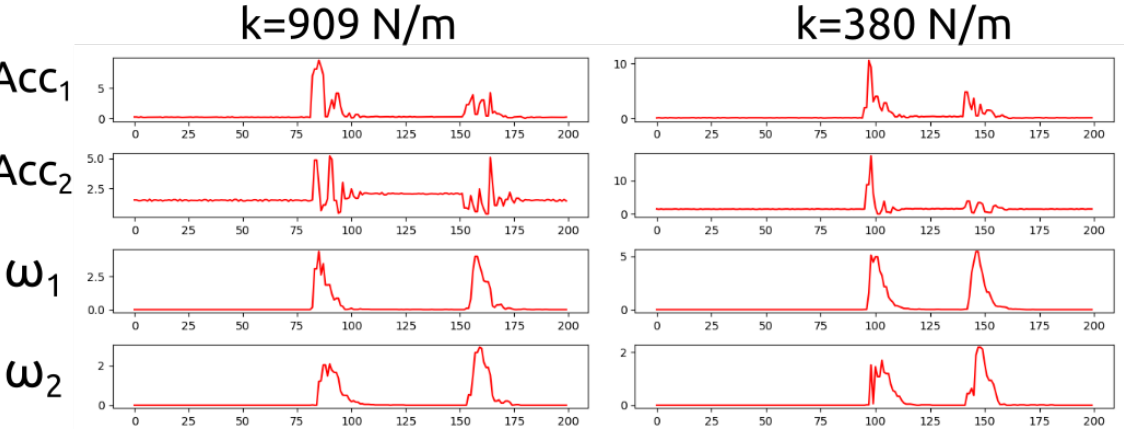
Figure 3. Comparison between exemplary samples from the real-world dataset while squeezing objects with different stiffness values with a soft gripper. Values a 1 , a 2 , ω 1 and ω 2 refers to the magnitude of registered accelerations and angular velocities and are expressed in m and rad s s 2